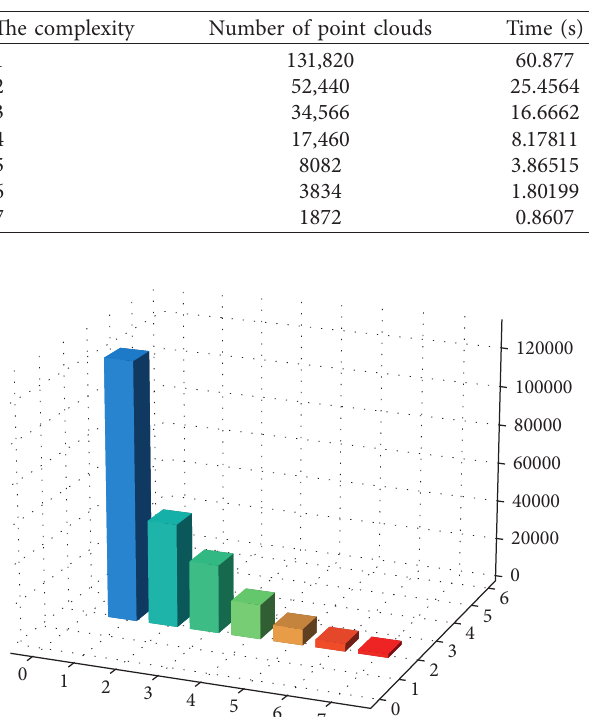
Table 1: Number of hematoma point clouds and calculation time.